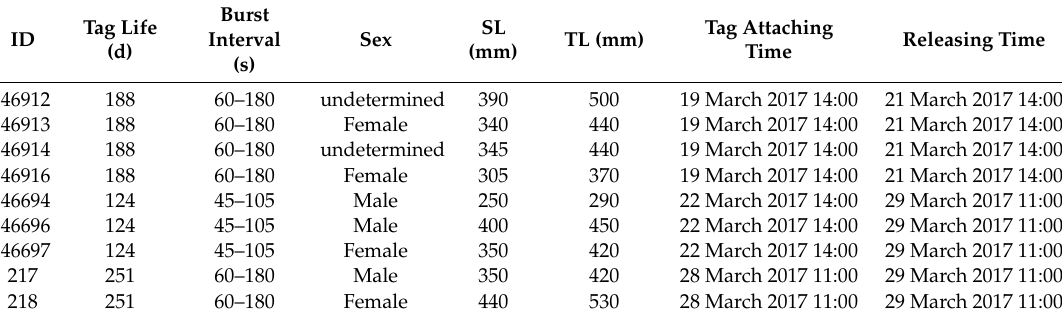
Table 1. Information on fish tags, the biological characteristics of the tagged common carp individuals, including sex, standard length (SL), and total length (TL), fish tag attachment time, and tagged fish release